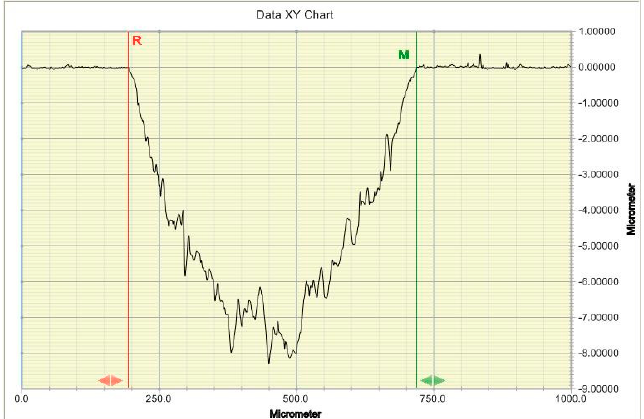
Figure 4. Typical 2D profile of dental material wear mark.